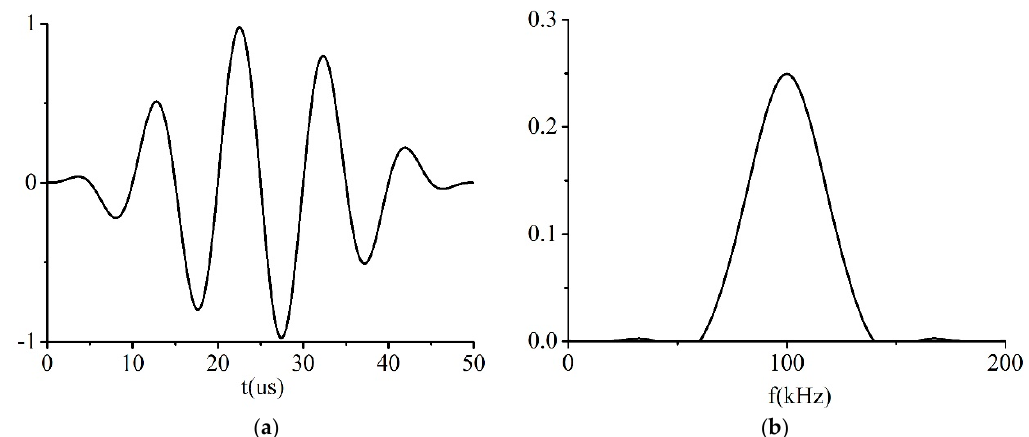
Figure 8. Excitation signal: ( a ) Temporal waveform; and ( b ) frequency spectrum.